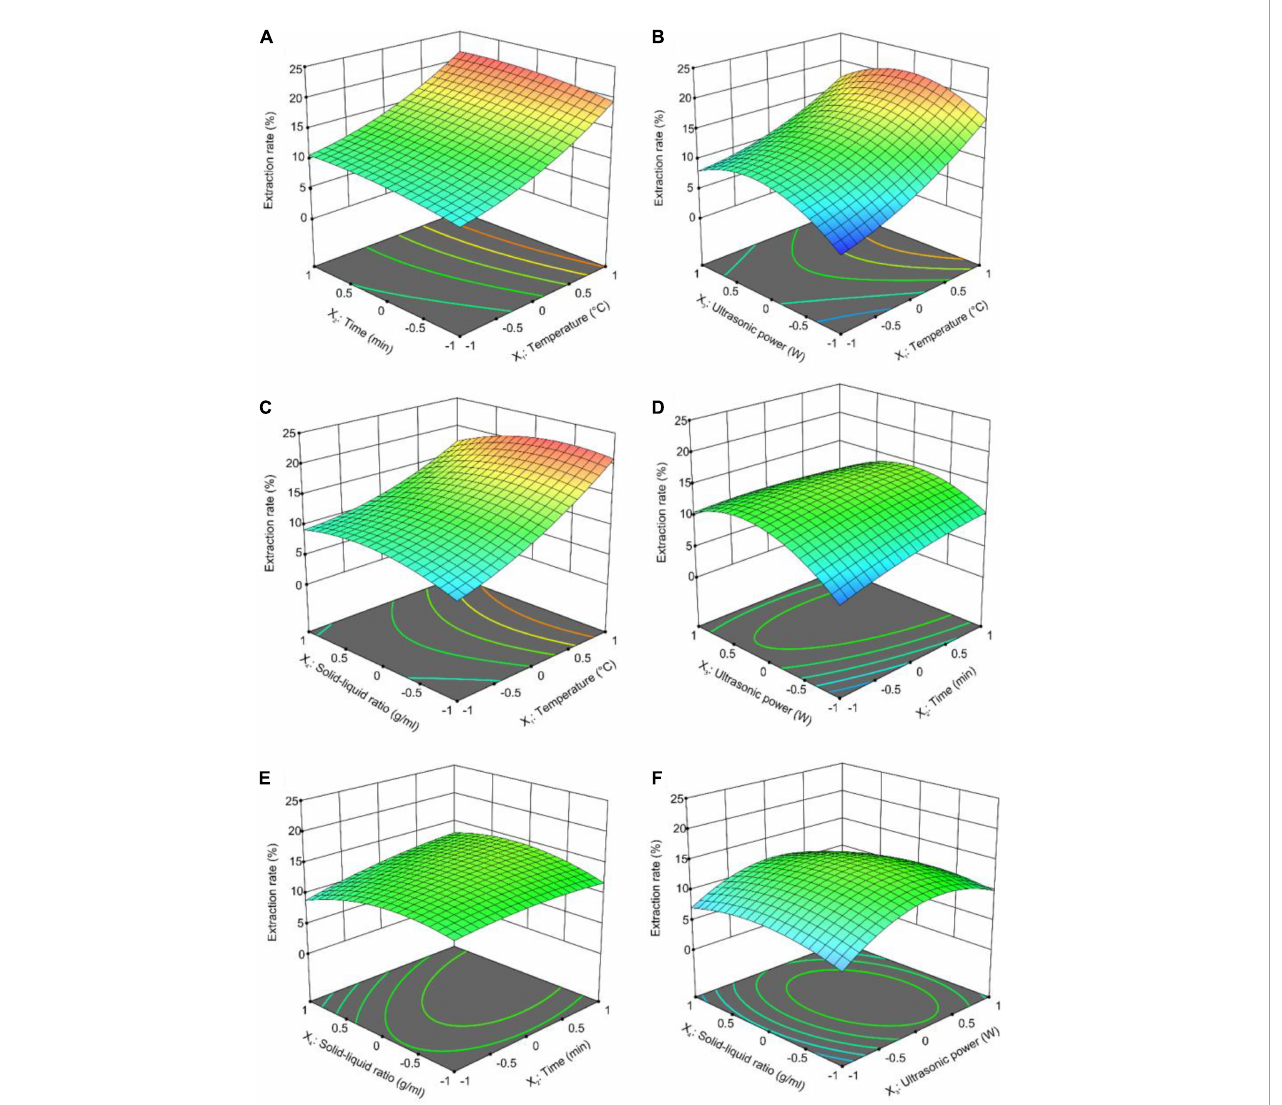
FIGURE2 Response surface plots (3D) for the ultrasound-assisted extraction of crude GFP: (A) Extraction time vs. extraction temperature; (B) ultrasonic power vs. extraction temperature; (C) solid-to-liquid ratio vs. extraction temperature; (D) ultrasonic power vs. extraction time; (E) solid-to-liquid ratio vs. extraction time; and (F) solid-to-liquid ratio vs. ultrasonic